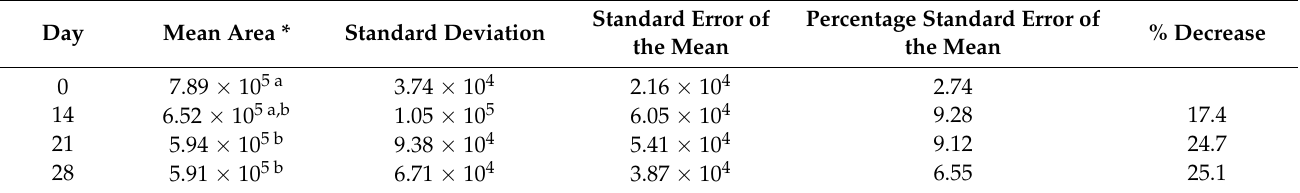
Table 4. Persistence interval of P. linaria essential oil.